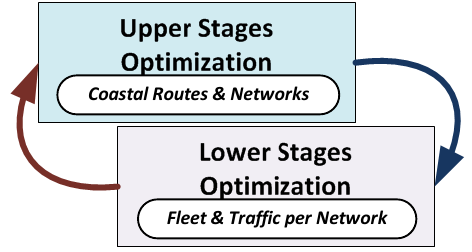
Figure 2: Bi-level optimization for the multi-stage system